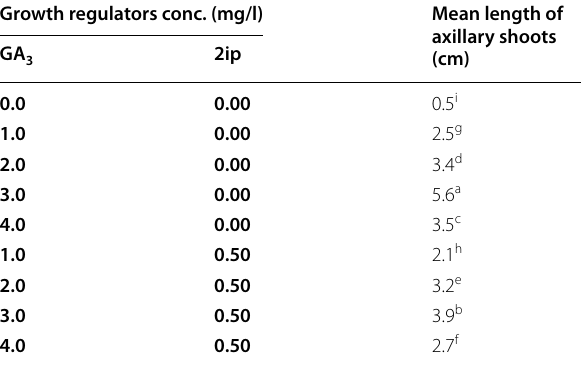
Table 4 Effect of different concentrations of GA shoots Growth regulators conc. (mg/l)